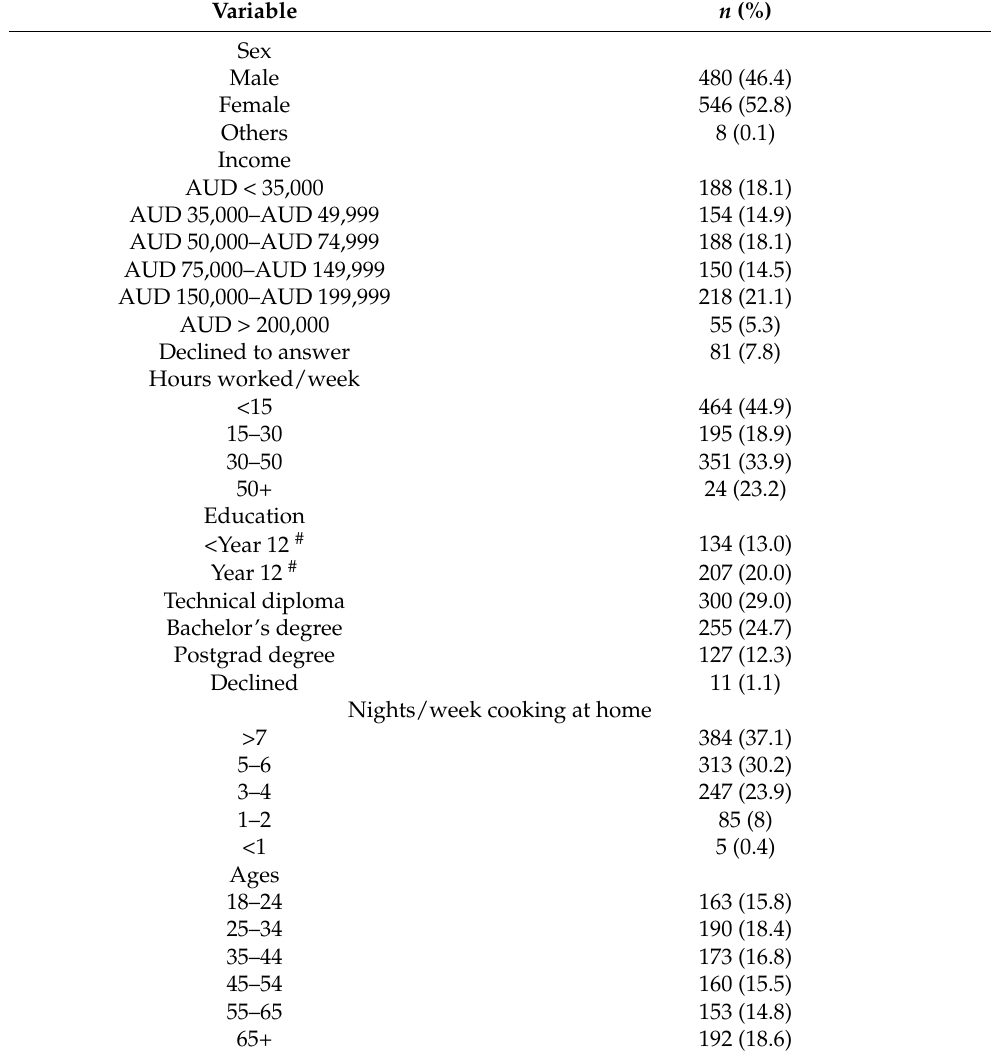
Table 1. Demographics characteristics of